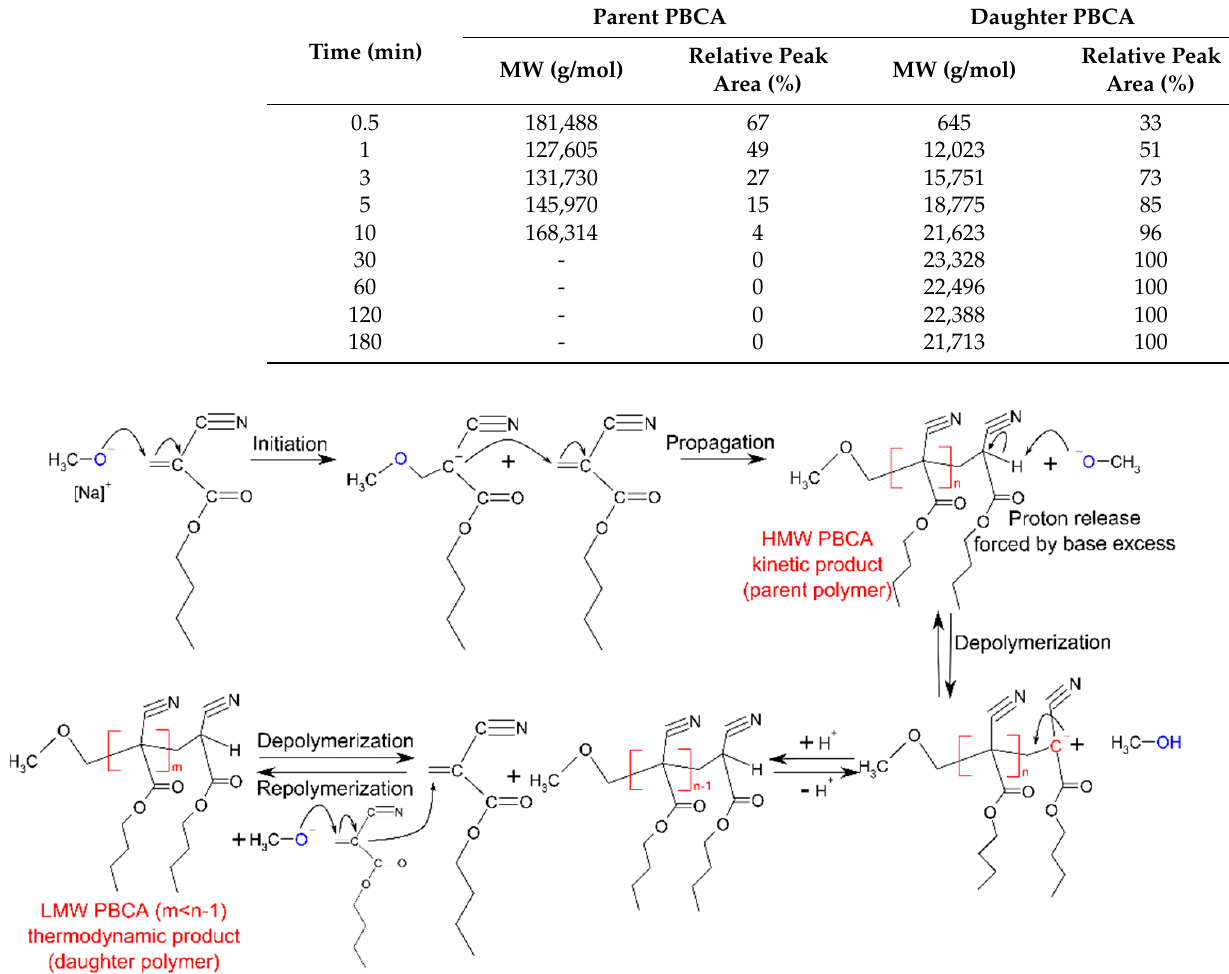
Figure 4. APC™ chromatogram of PBCA at different polymerization time points obtained with 5 mM NaOMe ( A ), 8 mM NaOMe ( B ), 40 mM NaOMe ( C ) and 75 mM NaOMe ( D ). The results in Figure 5 and Figure 6 indicate that the DPRP of PBCA is affected by the amounts of NaOMe, BCA and TFA. NaOMe at varying amounts had the most profound impact on the DPRP. With increasing amounts of NaOMe, the MW decreased significantly within 180 min of polymerization. The trend of decreasing MW dependent on the NaOMe amount was observed in all polymerization conditions, as detailed in Figure 5.